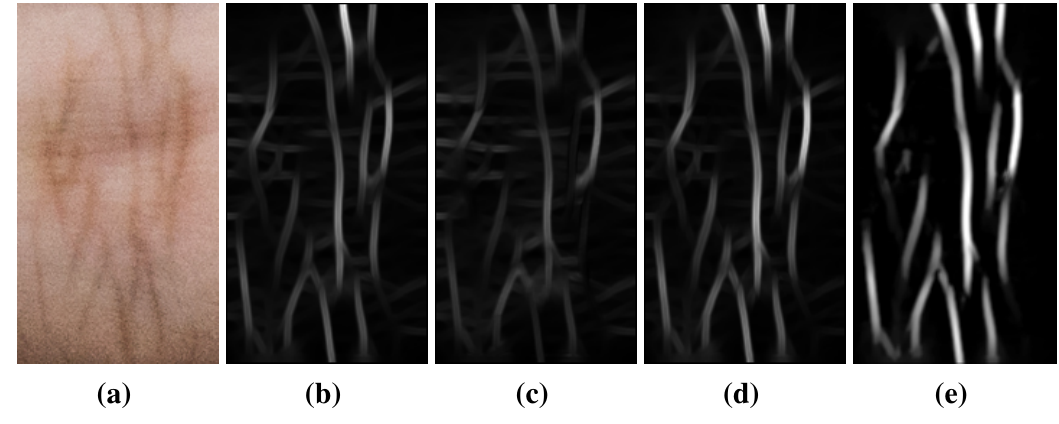
Figure 6. The feature refinement using our empirical model. ( a ) Original IKP image; ( b ) feature map after local and global extraction; ( c , d ) maximum energy maps based on (b) in the horizontal and vertical direction, respectively; ( e ) refined feature